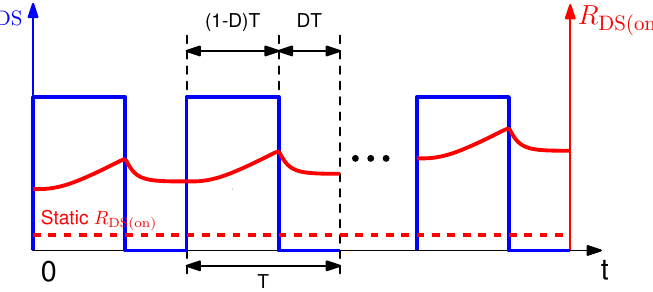
Figure 8. V DS bias effect on GaN-HEMT dynamic R DSon .